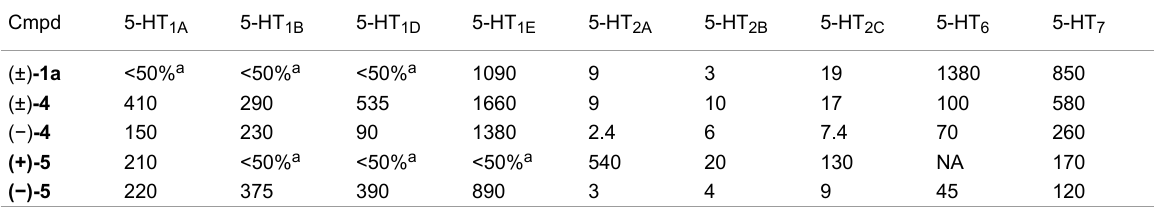
Table 3: Affinity values ( K i in nM) at selected serotonin receptor isoforms.